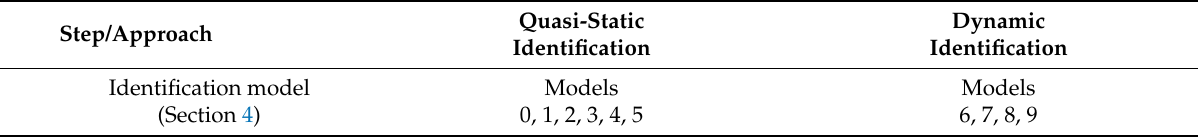
Figure 2. Left : Hexapod machine tool with rigid hexapod-based end-effector platform (setup 1b) including six structure- integrated 1DoF force sensors of the type Althen ALF256 5kN. Right : Corresponding values for measurement model. The integration of the sensors, which are screwed in after cutting, drilling, and thread-cutting the bars of the existing end-effector, is fast, cheap, and does not change mass or size of the end-effector, significantly. Table 1. Overview of approach, variations and